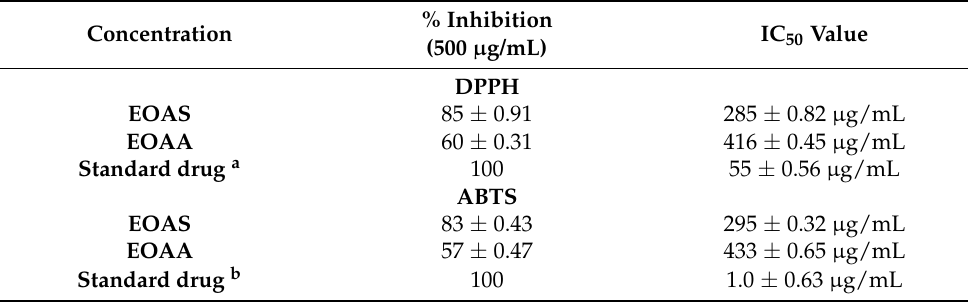
Table 3. DPPH and ABTS free radical scavenging effects of EOAS and EOAA.